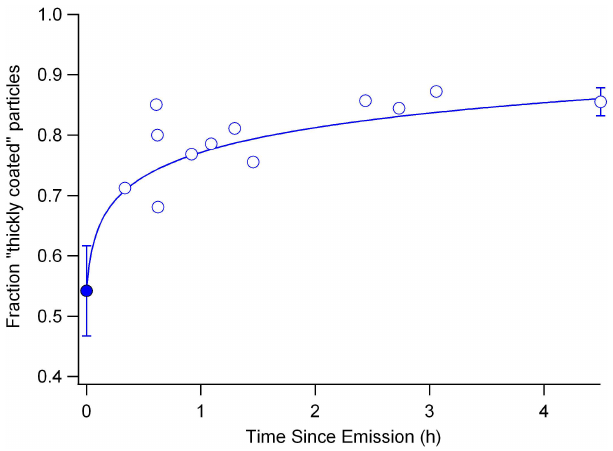
Fig. 12. Fraction of “thickly coated” (fTC) rBC particles vs. time since emission (h). Individual source sample fTC fractions are not shown and we instead show the mean fraction of source samples at t = 0h (solid circle) with an error bar reflecting the standard devi- ation of the mean. The downwind error bar is an estimate of the uncertainty in the oldest individual downwind sample. Points were fit to a logarithmic